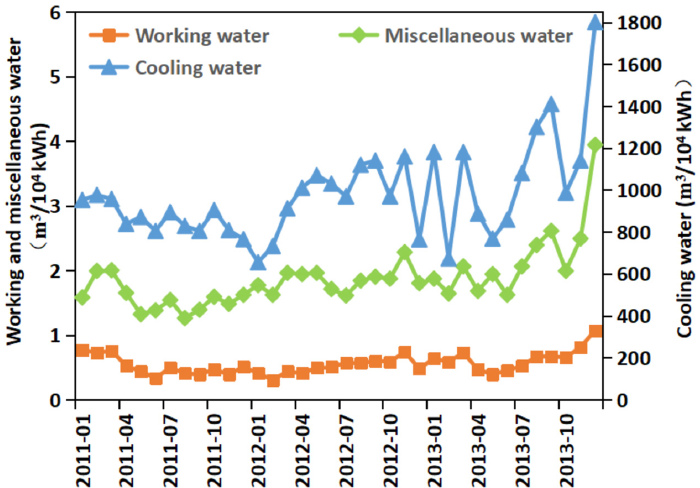
Figure 7. Water consumption for electricity generation at the Mawan coal-fired power plant from January 2011 to December 2013.